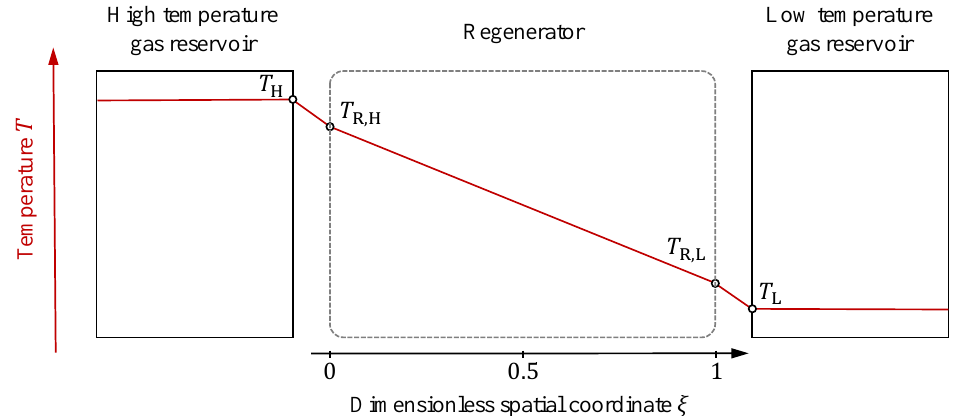
Figure 6. Schematics of the regenerator with a linear spatial temperature distribution connecting its contact point temperatures T R,H and T R,L . The temporal evolution of the contact point temperatures T T R,H and R,L results from the dynamics of the regenerator. Between the contact point temperatures and the temperatures of the adjacent gas reservoirs T H and T L , temperature differences may occur so that gas flows to or from the regenerator result in thermal mixing. This thermal mixing will in the following be referred to as an external irreversibility of the